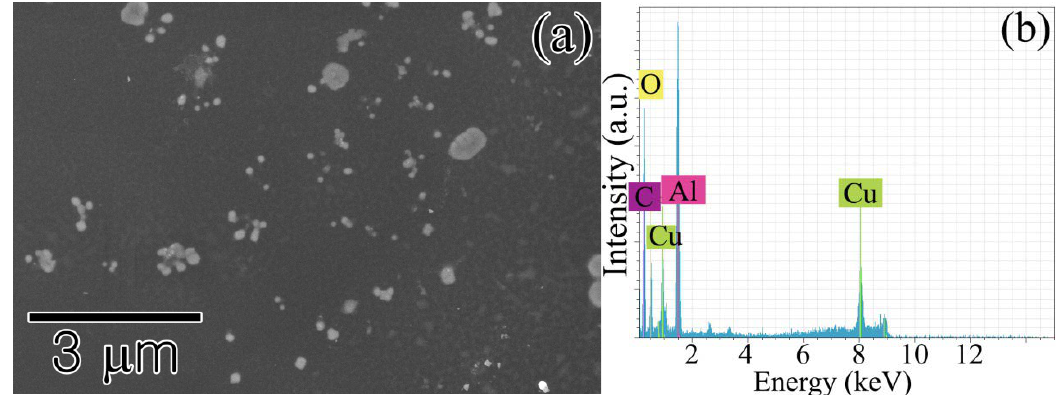
Figure 2. ( a ) Al oxide nanocrystallites formed on a TEM grid placed on top of an amorphous alloy ribbon during annealing at 573 K for 15 min; ( b ) EDX analysis